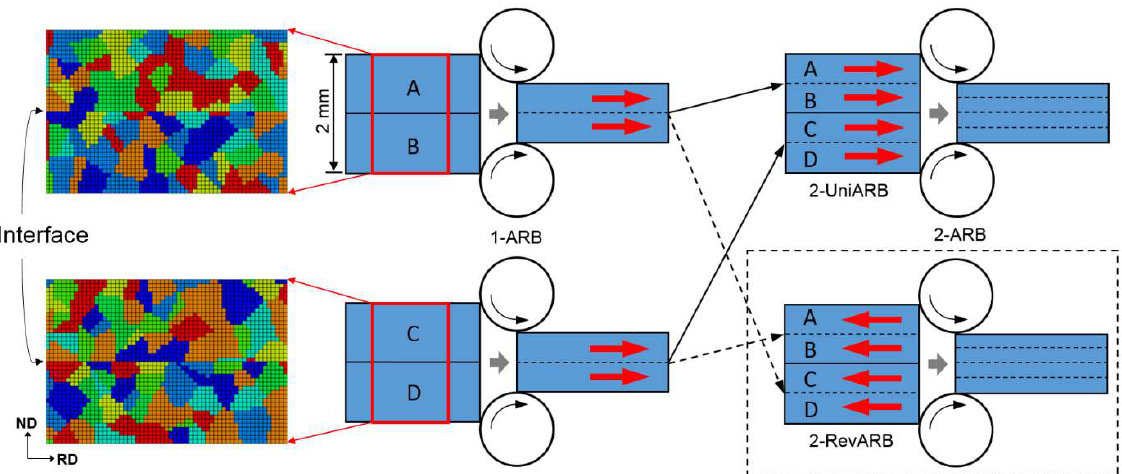
Figure 1. Finite element method (FEM) model of unidirectional accumulative roll-bonding (UniARB) and reverse accumulative roll-bonding (RevARB), and two representative regions of polycrystal structures. The red arrows indicate the direction of the imposed deformation. 1-ARB: first ARB cycle; 2-ARB: second ARB cycle; ND: normal direction; RD: rolling direction.